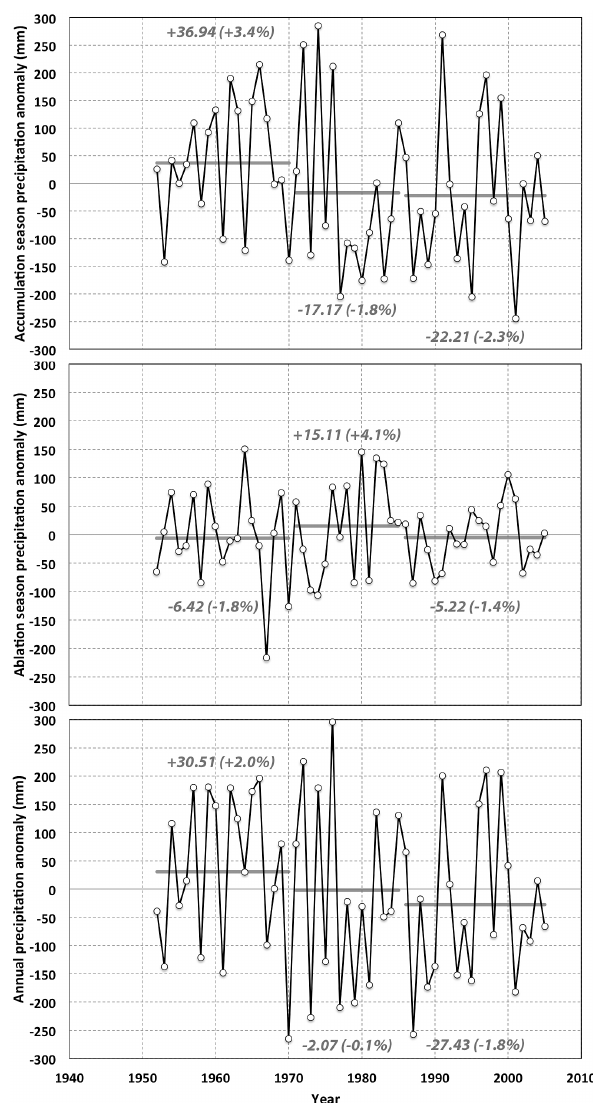
Figure 11. ClimateWNA precipitation records of deviation from the long-term (1952–2005) mean of (a) total accumulation-season pre- cipitation, (b) total ablation season precipitation, and (c) total an- nual precipitation. Gray bars and values indicate averages for the periods 1952–1970, 1970–1985, and